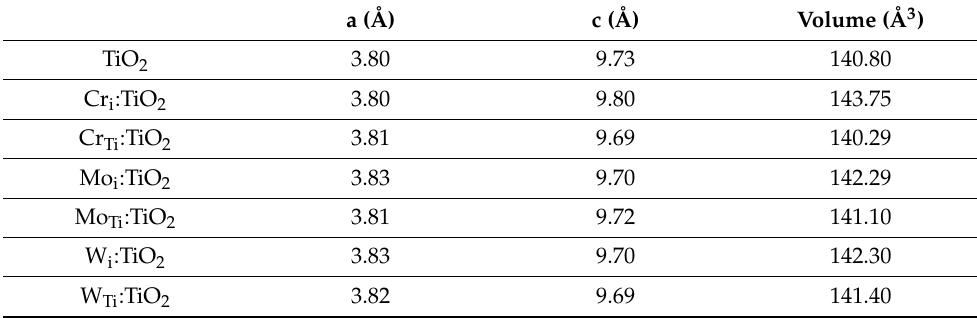
Table 1. Lattice parameters and cell volume for every doping